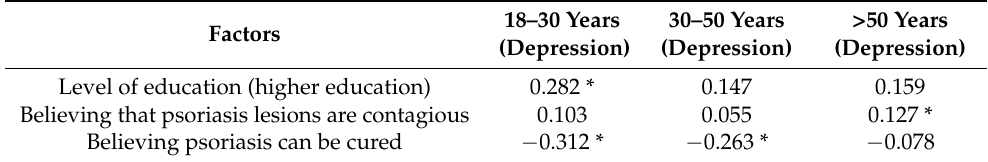
Table 6. Correlation analysis by age